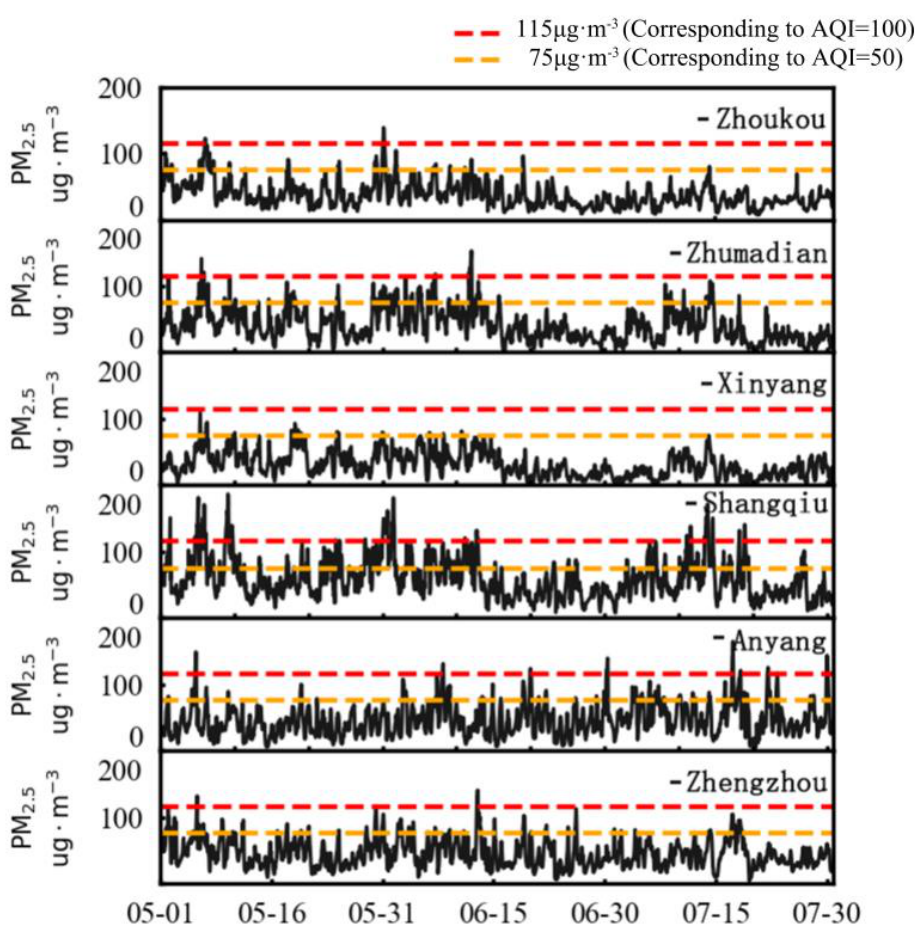
Figure 2. Time variation of pollutant concentration.